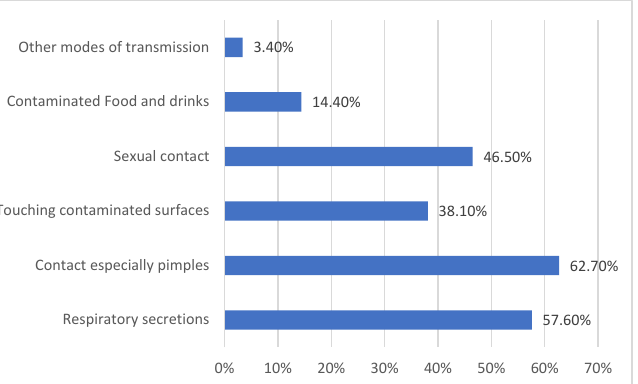
Figure A1. Public perceptions of monkeypox disease transmission modes. (KSA, 27 May to 5 June 2022.)